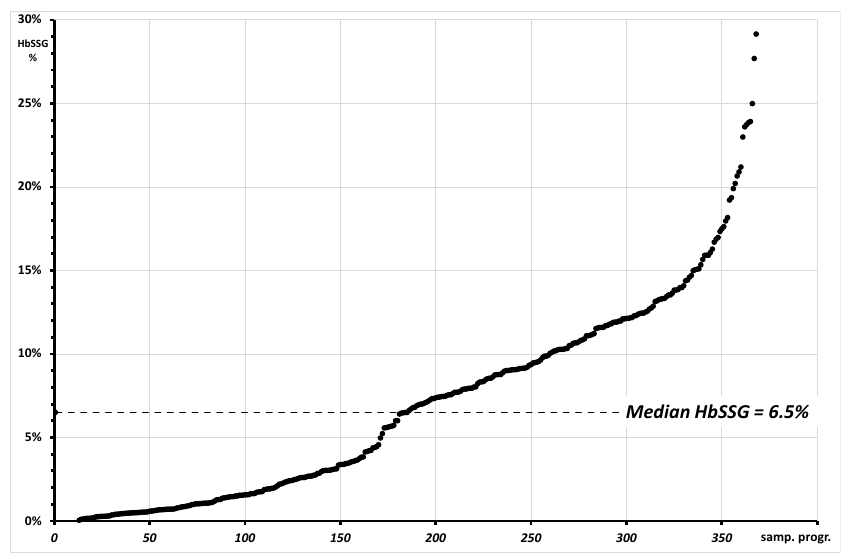
Figure 7. Plot of the cumulative distribution of 368 measurements of glutationyl hemoglobin with values spanning from “not measurable” (approx. <0.1%; 23/368) to approx. 30%. The graph reports as a dotted line the median value of HbSSG in the measured samples.